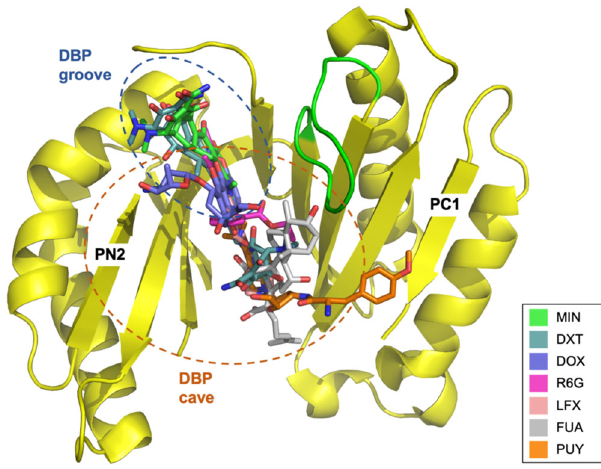
Fig. 5 Overlay of substrates bound to the DBP of the AcrB T conformation. Superposition of the coordinates of minocycline (MIN; carbon = green; PDB: 4DX5), doxycycline (DXT; carbon = blue-green; this study), doxorubicin (DOX; carbon = violet; PDB: 4DX7), rhodamine 6G (R6G; carbon = pink; PDB: 5ENS), levo fl oxacin (LFX; carbon = salmon; this study), fusidic acid (FUA; carbon = gray; this study) and puromycin (PUY; carbon = orange; PDB: 5NC5) indicate partially overlapping binding sites throughout the DBP. Substrates are shown as sticks, the AcrB PN2/ PC1 subdomains are represented as yellow cartoon. The switch loop is in